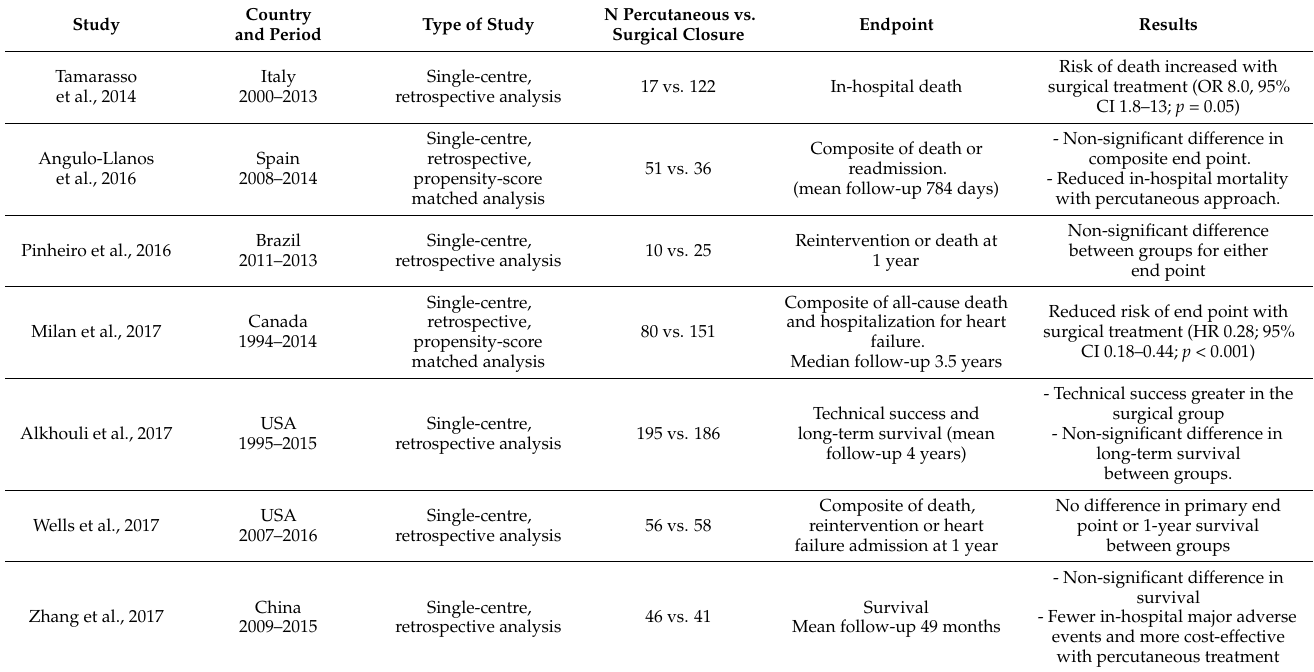
Table 2. Percutaneous vs. surgical PVL mitral